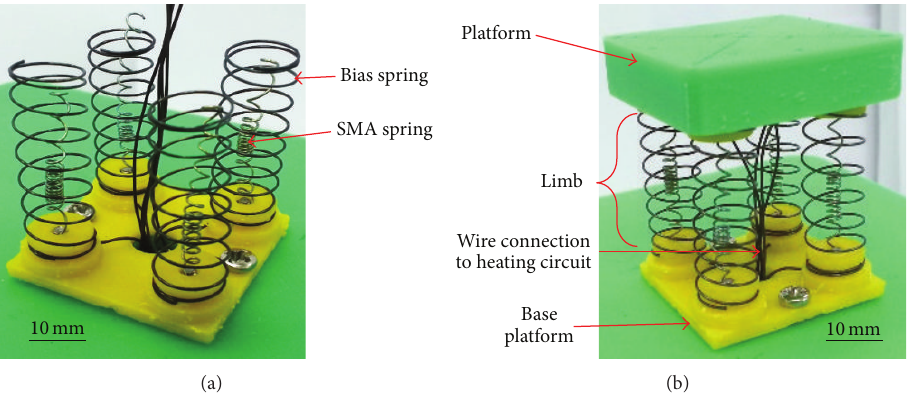
Figure 6: Fabrication results: (a) limbs attached to base platform; (b) complete prototype.